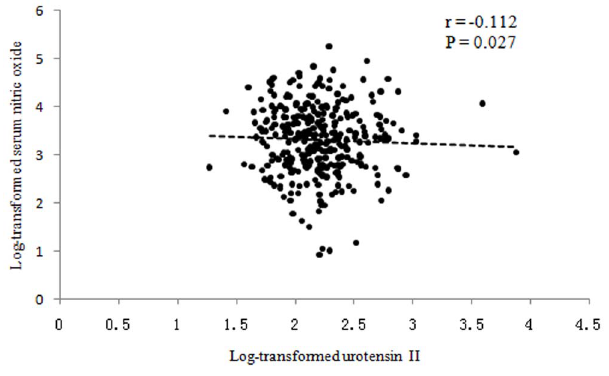
Figure 2. Correlation between plasma urotensin II and nitric